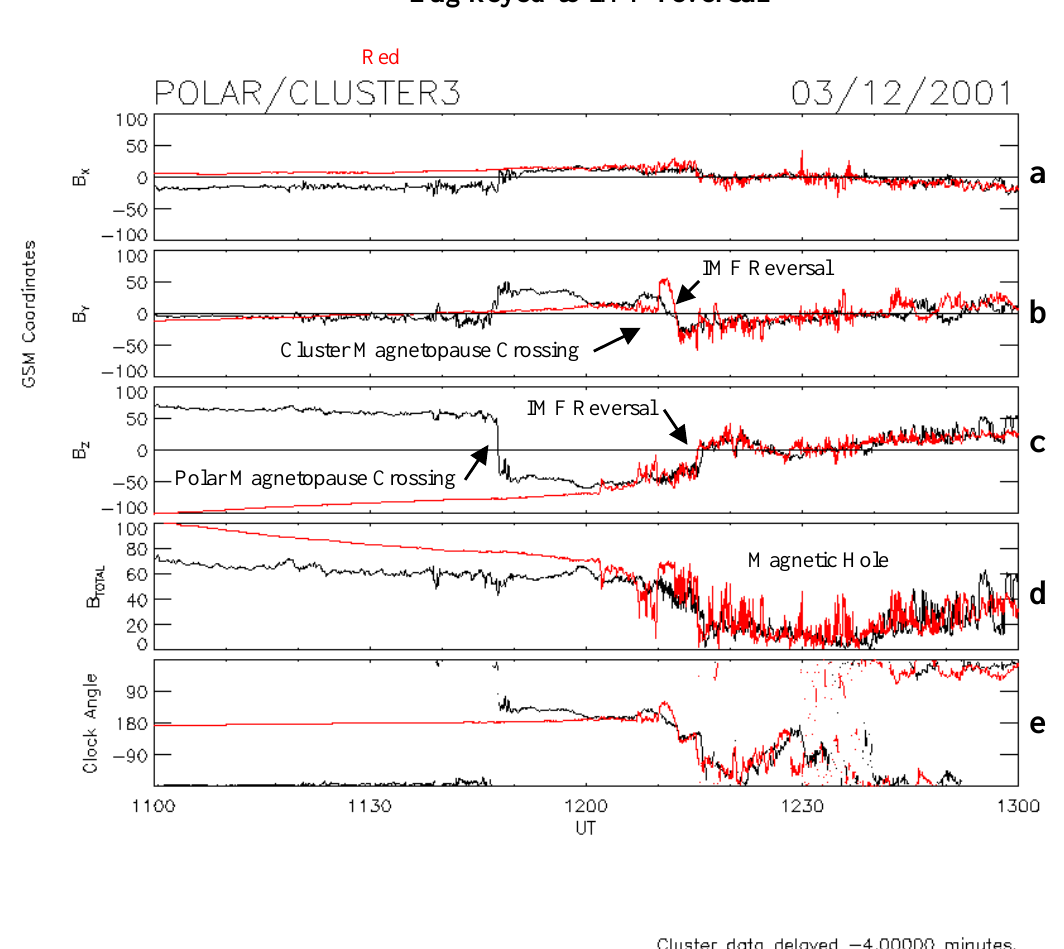
Fig. 11. Overlay of the Polar and Cluster 3 magnetometer data. The Cluster data is delayed − 4min. Note that once Cluster has exited the current layer at the boundary the measured magnetic fields in the magnetosheath match in magnitude, direction and clock